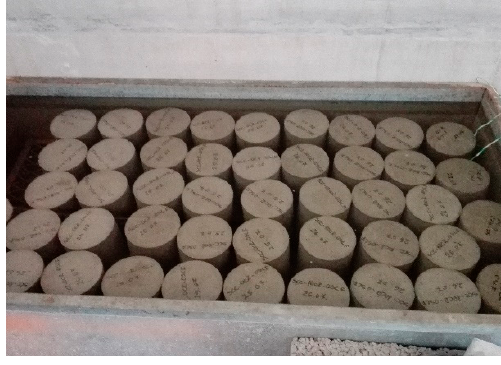
Figure 4. Pan mixer (50 L capacity).